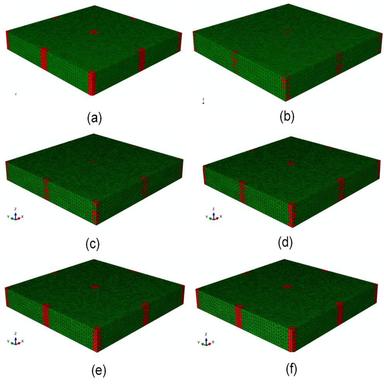
FEA model with junction area void defects: (a) Junction area; (b) FEA model of junction area void defects, (c) FEA model with 1% volume defects, (d) FEA model with 2% volume defects, (e) FEA model with 4% volume defects, (f) FEA model with 5% volume defects.